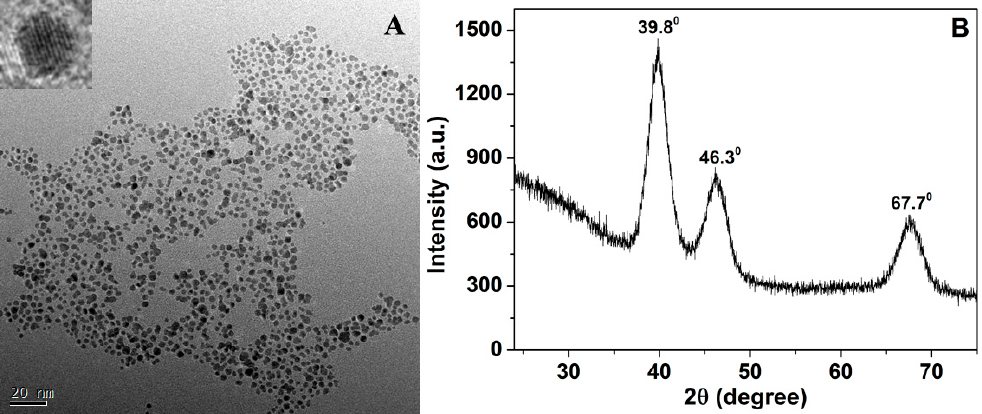
Figure 1 . ( A ) TEM image of citric acid-modified PtNPs (Inset: HRTEM image of citric acid-modified PtNPs); and ( B ) XRD patterns of the PtNPs.